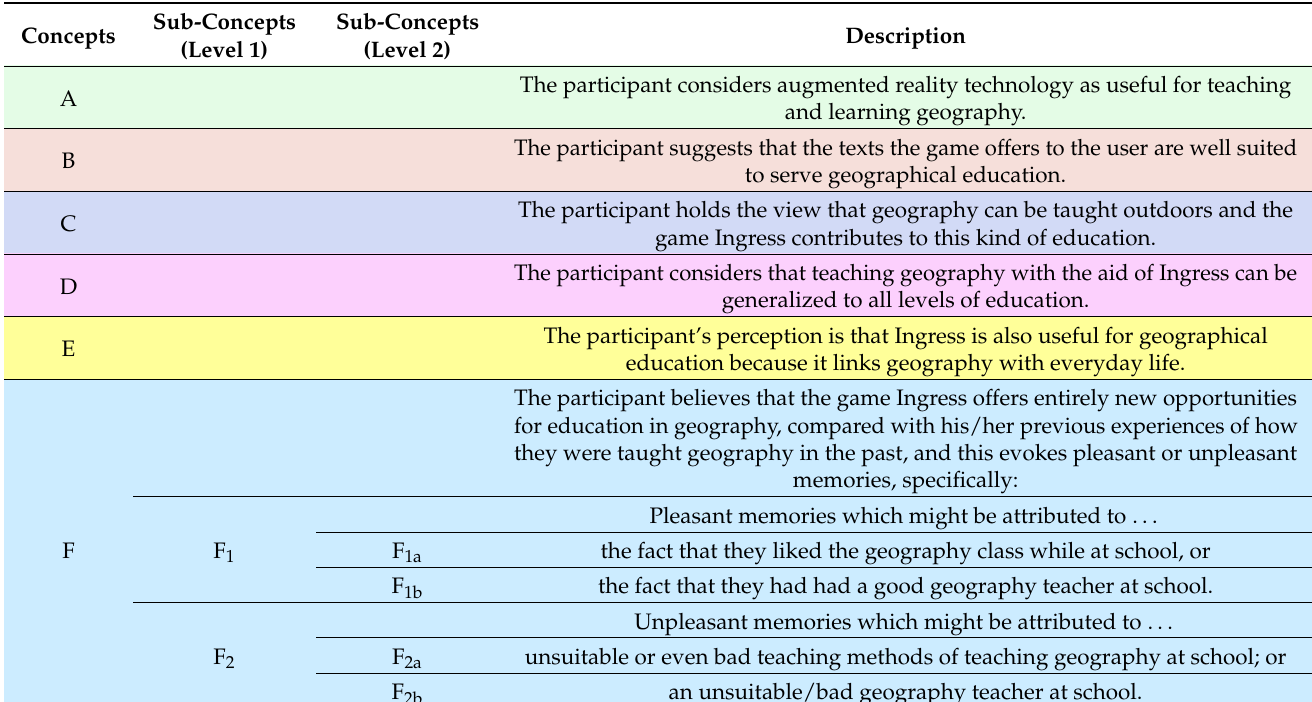
Table 3. Table showing the concepts and sub-concepts of Q 2 (see text for explanation).